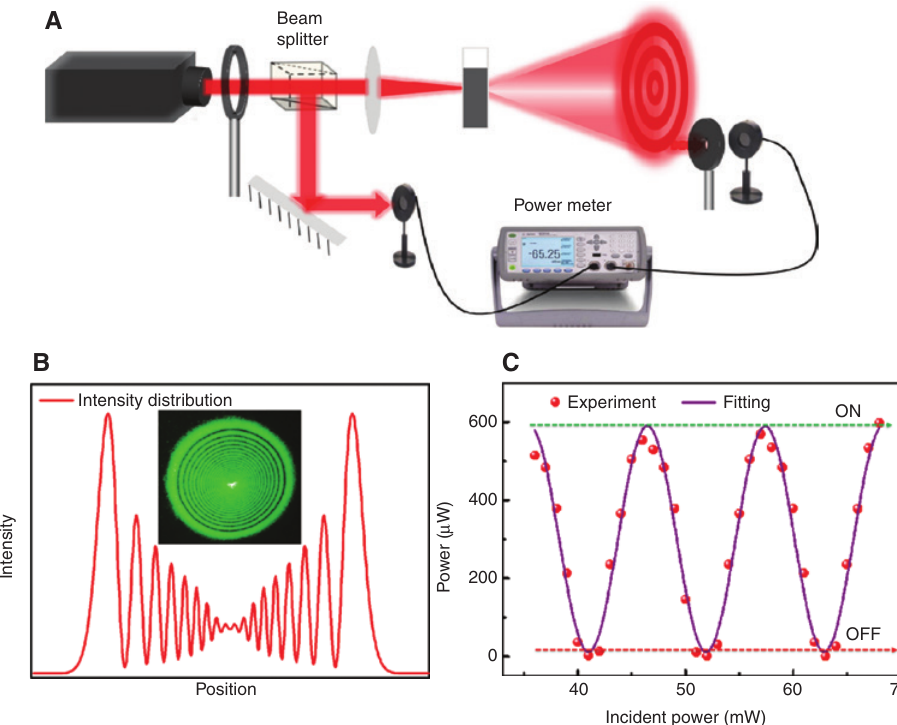
Figure 5: The theory and experiment of all-optical switch. (A) All-optical switch schematic based on the monochromatic light, (B) theoretical intensity distribution of diffraction rings, and (C) experimental data of all-optical switch